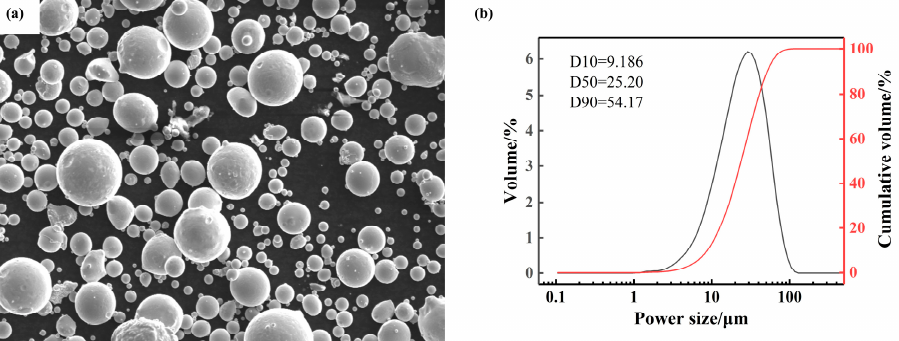
Figure 3. ( a ) The micromorphology of FeCrAl alloy powders and ( b ) the particle size